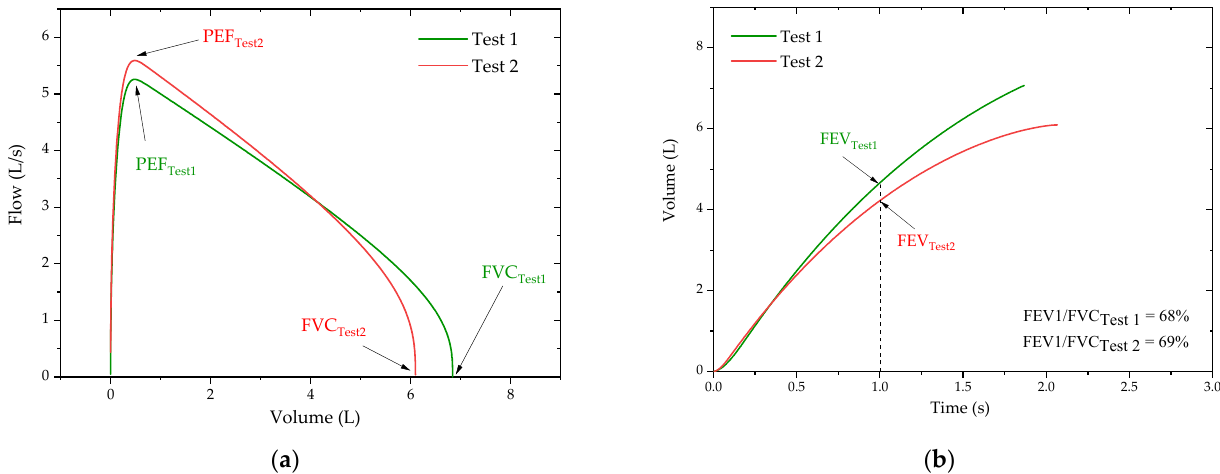
Figure 9. Spirometry curves for two different tests obtained with the proposed system: ( a ) flow–volume curve; ( b ) volume–time curve.